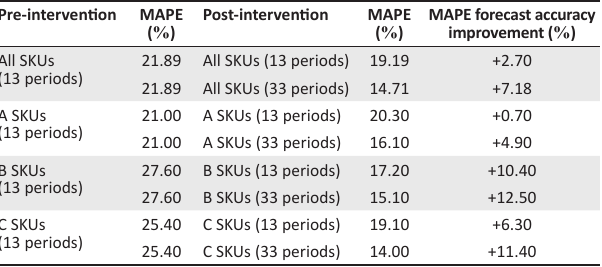
MAPE forecast accuracy ( % ) improvement ( % )